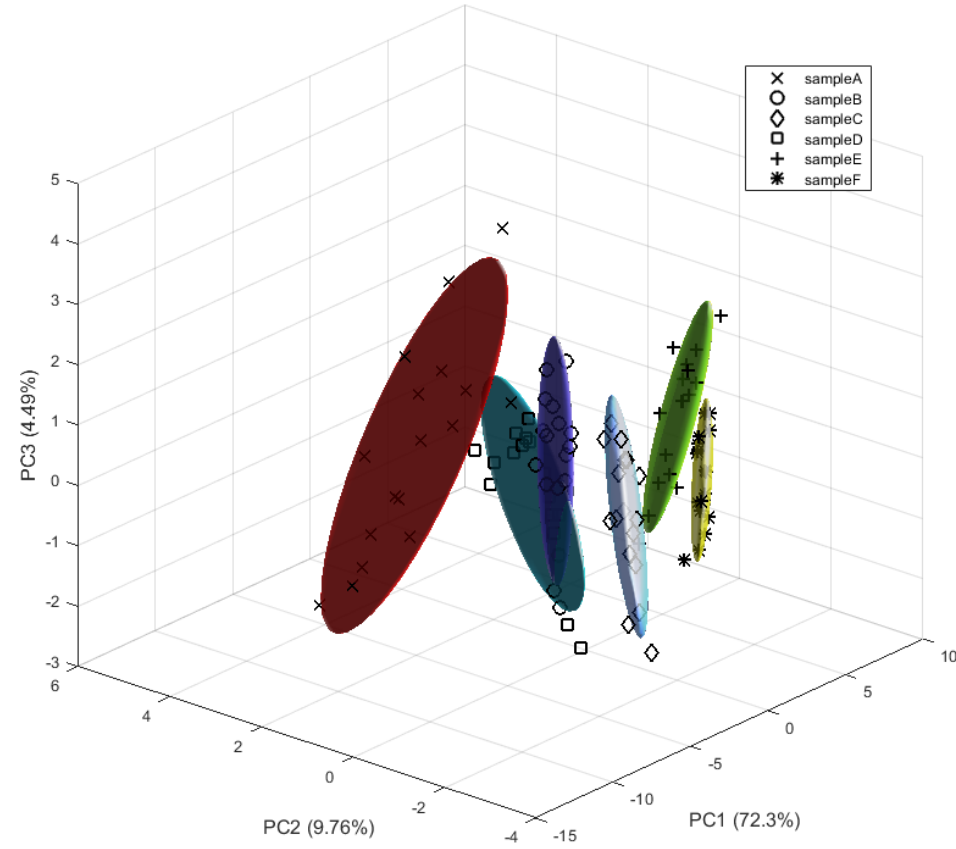
Figure 8. PCA plot for measurements with granulated corks at different concentrations.